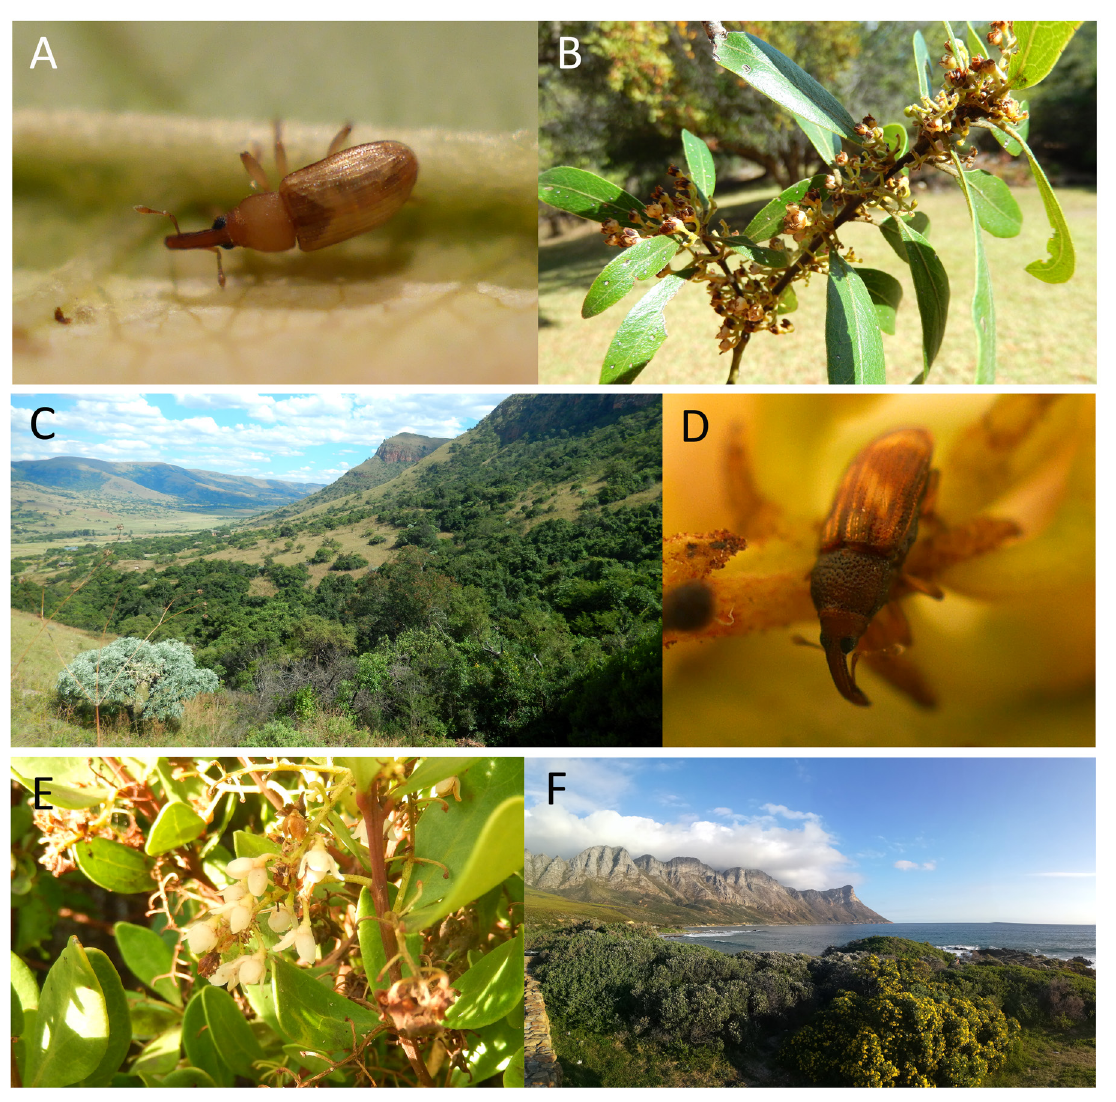
Fig. 7. Habitus in natura, host plants and habitats of Ebenacobius Haran gen. nov. A . Habitus of adult of E. rectirostris Haran gen. et sp. nov. B . Inflorescence of Euclea natalensis A.DC. (Ebenaceae), host of E. rectirostris . C . Biotope of E. rectirostris in the Mpumalanga Province of South Africa. D . Habitus of adult of E. san Haran gen. et sp. nov. E . Inflorescence of Euclea racemosa L. (Ebenaceae), host of E. san. F . Biotope of E. san in the Western Cape Province of South